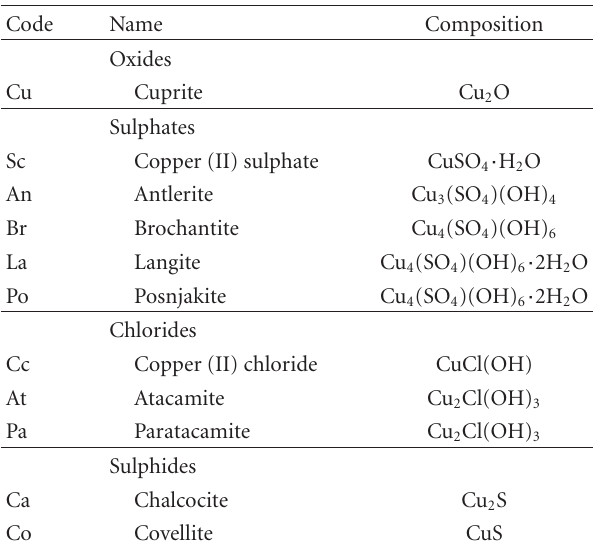
Table 9: Copper corrosion products identified in the MICAT project.